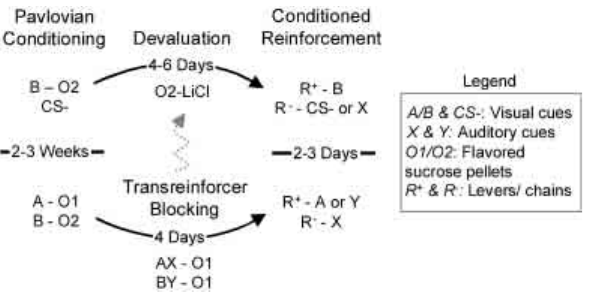
Figure 1. Outline of behavioral training . Rats underwent simple Pavlovian conditioning followed by either devaluation (top of figure-data in Sections Con- ditioned Reinforcement Mediated by Devaluation-Insensitive Representations of General Affect and Role of Amygdala in Conditioned Reinforcement; note five rats out of the group received blocking then devaluation, indicated by gray